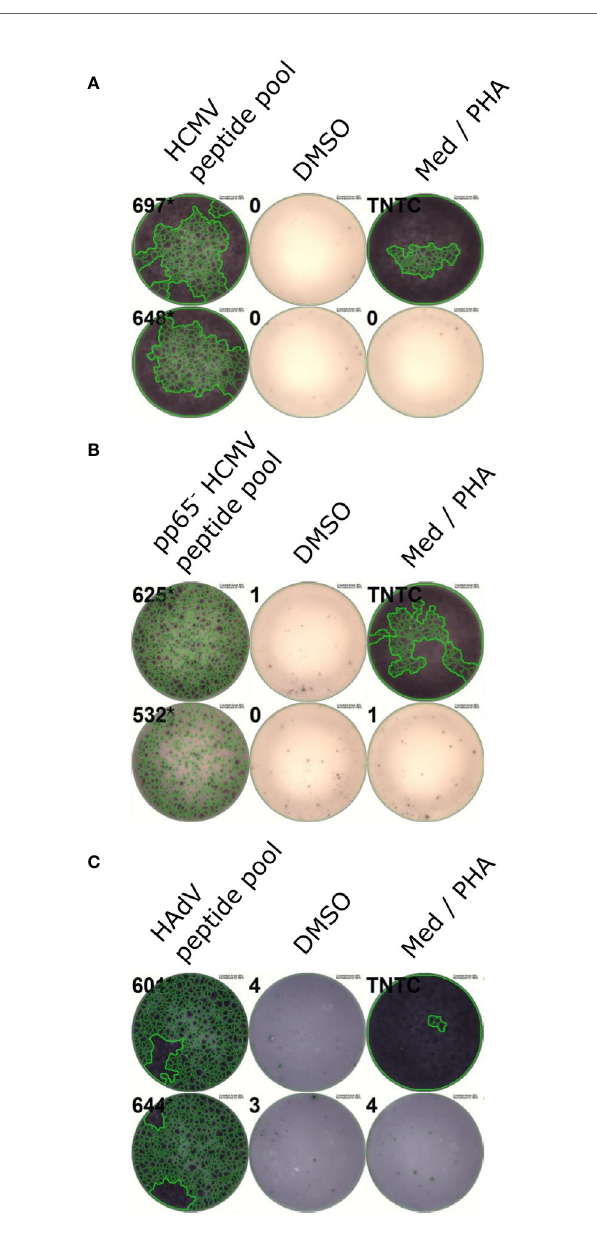
FIGURE 7 | Representative ELISpots of peptide pools. PBMCs were incubated with peptide pools in ELISpot assays after a 12-day stimulation. Representative ELISpot wells for the HCMV peptide pool (A) , the pp65 - HCMV peptide pool (B) , and the HAdV peptide pool (C) are shown. DMSO served as a negative control, PHA as a positive control. Med, Medium